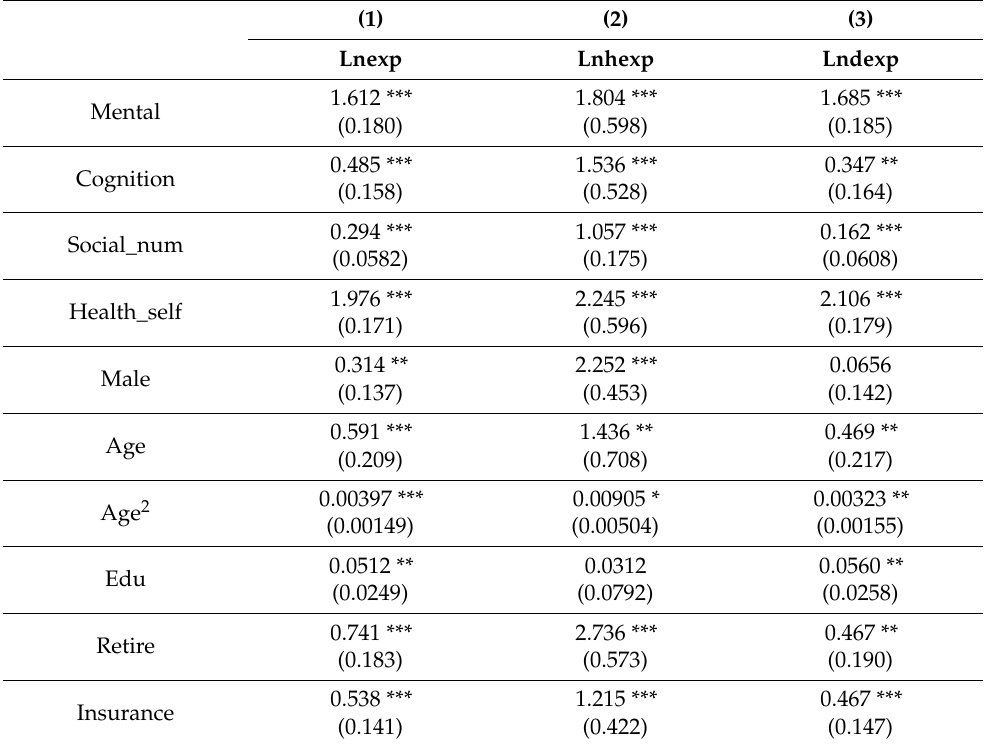
Table 6. Regression results of the Tobit